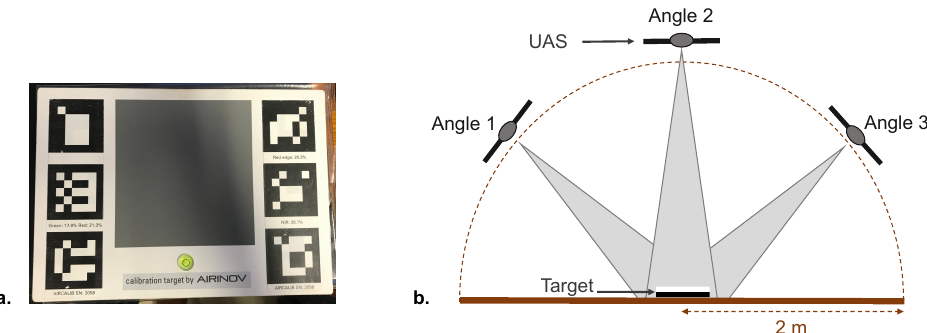
Figure 1. ( a ) Target used for the one-point calibration, one-point calibration plus sunshine sensor, and one-point calibration plus sunshine sensor plus post-calibration radiometric calibration methods. Target true reflectance was 17.9% in the green, 21.3% in the red, 26.3% in the red-edge, and 36.1% in the near-infrared. ( b ) Method used to take pictures of the calibration target at the time of